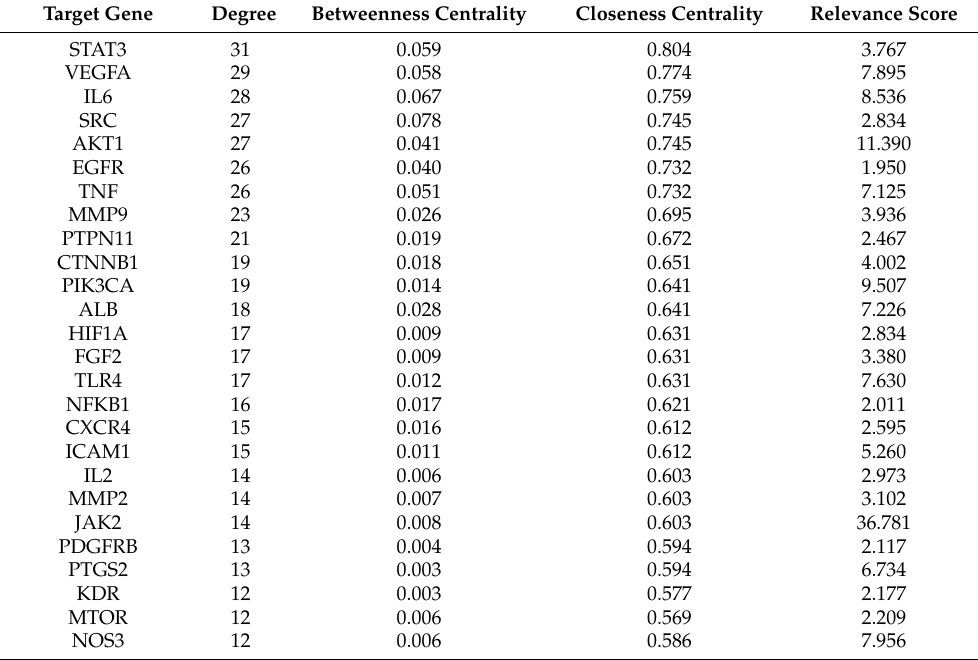
Figure 2. PPI networks: ( A ) PPI network of potential targets; ( B ) PPI network of key targets. Table 1. Key targets based on PPI network topological analysis.